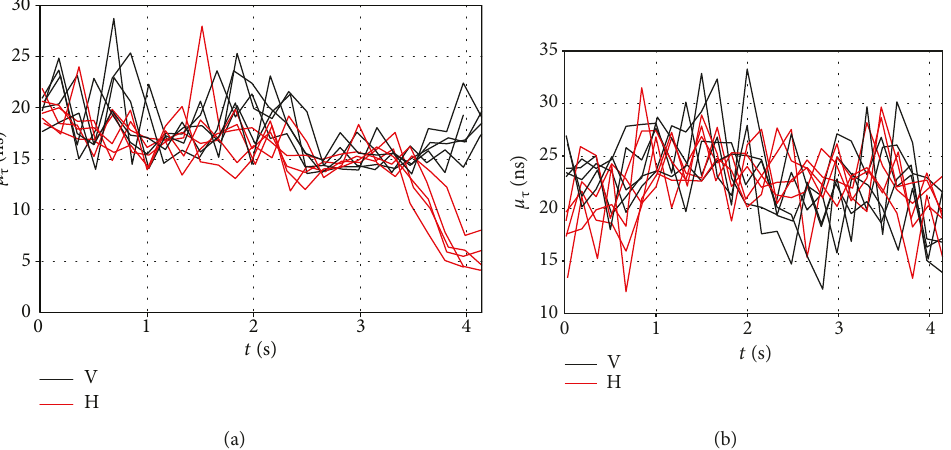
t ), for the V- and H-polarized on-body antenna placed on TO τ ) vs. time (